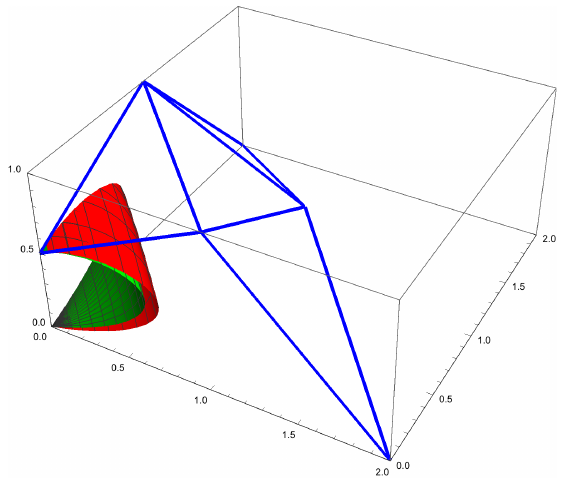
called a truncated triangular Meyer-König-Zeller surface.